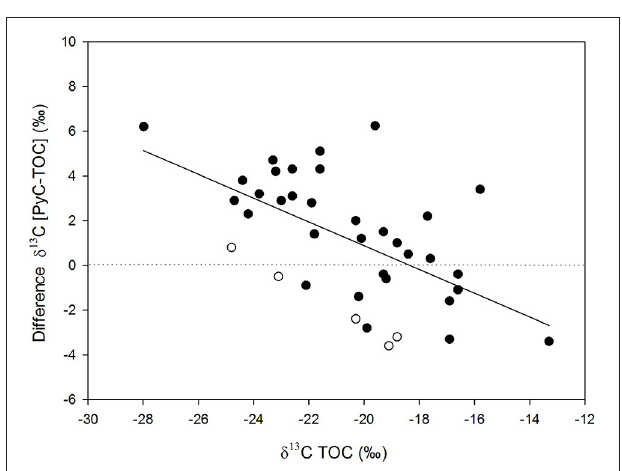
FIGURE 6 | Relationship between the relative contribution of PyC to TOC (%) and differences in δ 13 C between the PyC component and the TOC pool; r 2 0.19; p < 0.05. Open symbols correspond to samples with very coarse texture ( n = 5).